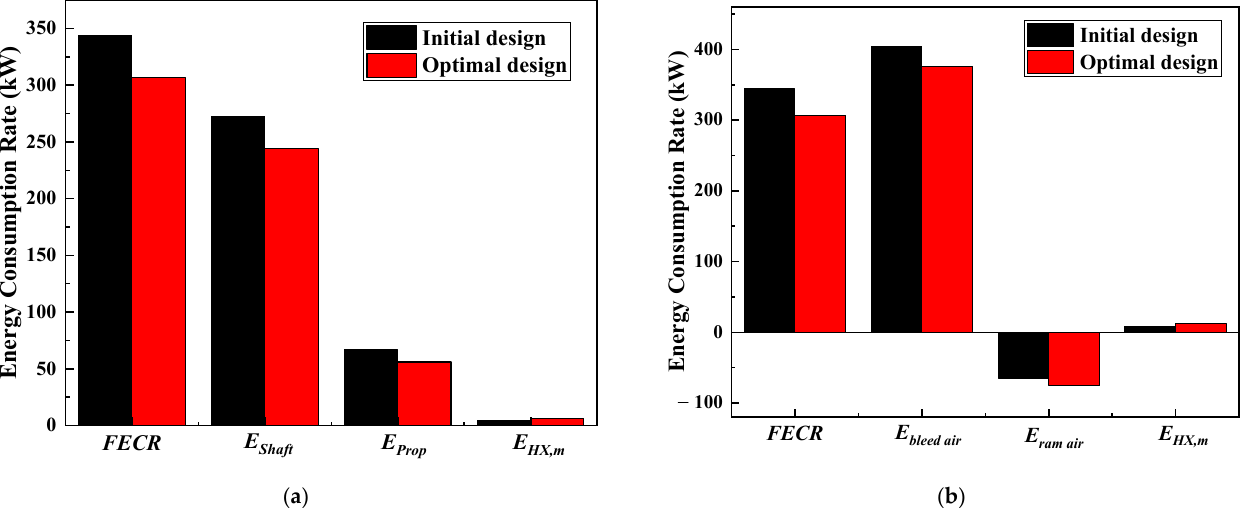
Figure 8. Comparison of energy consumptions. ( a ) sorted by energy form; ( b ) sorted by airstreams.